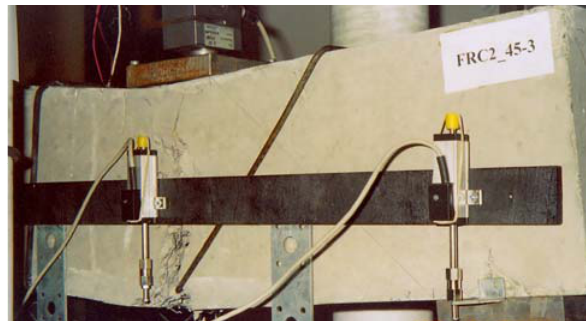
Fig 4. Failure of specimens ( / 1,5 a h = )